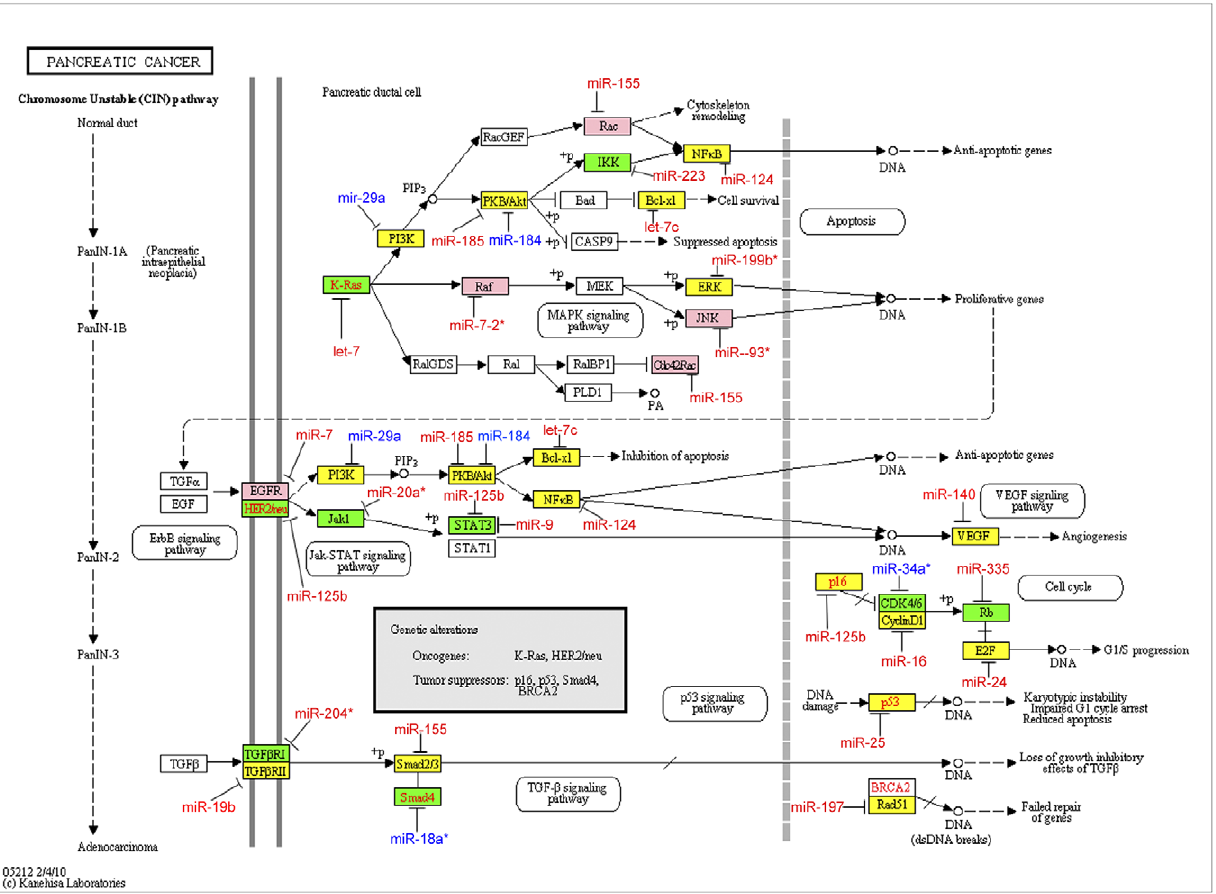
Figure 3. Genes in the pancreatic cancer pathway containing SNPs and indels that altered experimentally supported target sites. Genes containing only indels (pink), only SNPs (yellow), and both SNPs and indels (green) in target sites are within colored rectangles. The miRNAs that have been shown to target these genes are shown with red text for disrupted sites and blue text for created sites. doi:10.1371/journal.pone.0046176.g003 PLOS ONE |